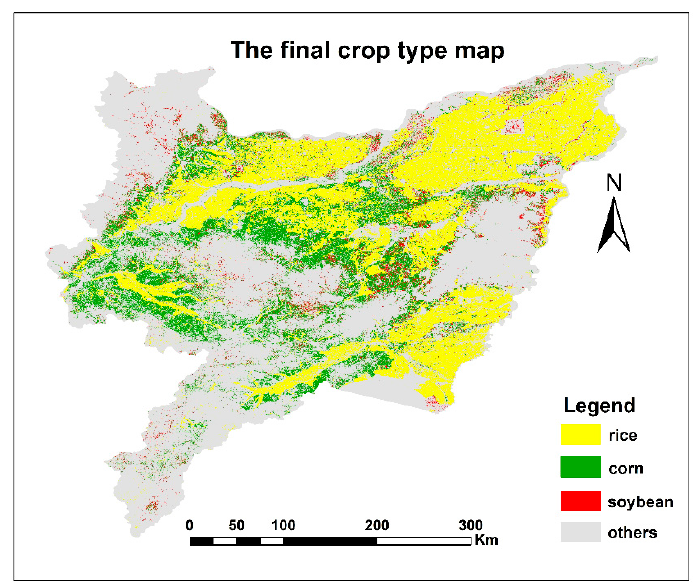
Figure 8. Crop map based on the probability map of corn, rice, and soybean based on optimized feature selection.